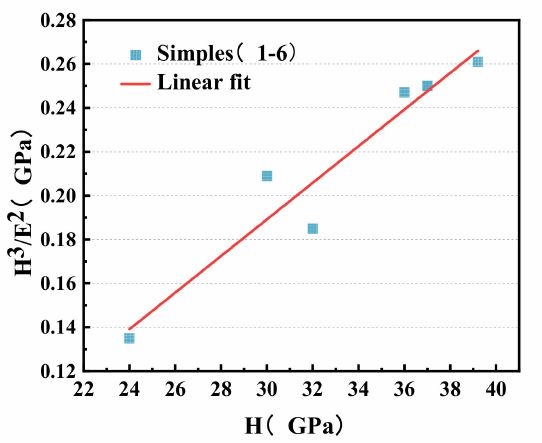
Figure 11. Dependence of toughness H 3 /E 2 on hardness